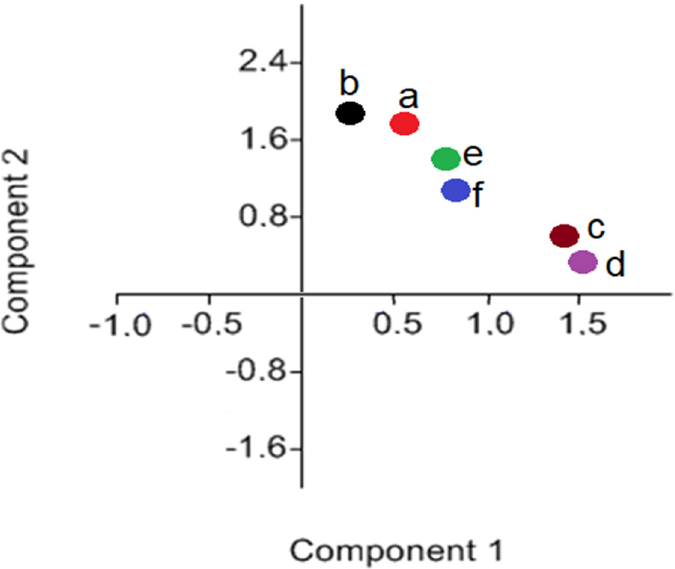
Figure 4. Principal component analysis (PCA) analysis of the FTIR spectra of oats: ( a ) control, ( b ) without water, ( c ) with 0.5% of algae, ( d ) with 1% of algae, ( e ) with 5% of algae, and ( f ) with 10% of algae. The PCA analysis was done in the IR region between 800 and 1800 cm − 1 .